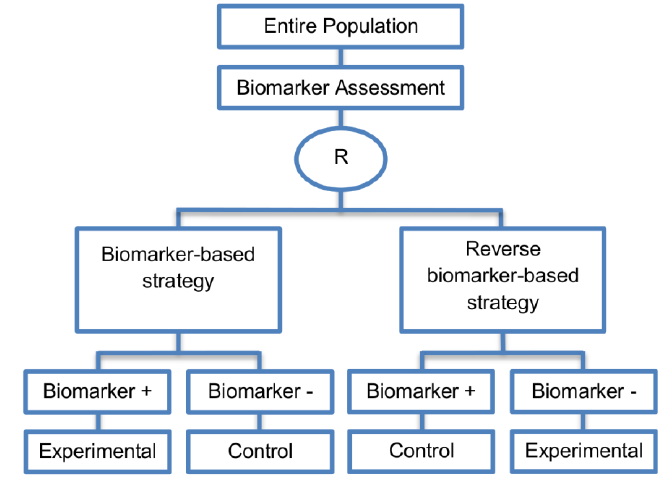
Figure 15. Reverse Marker- Based strategy design. “R” refers to randomization of patients.